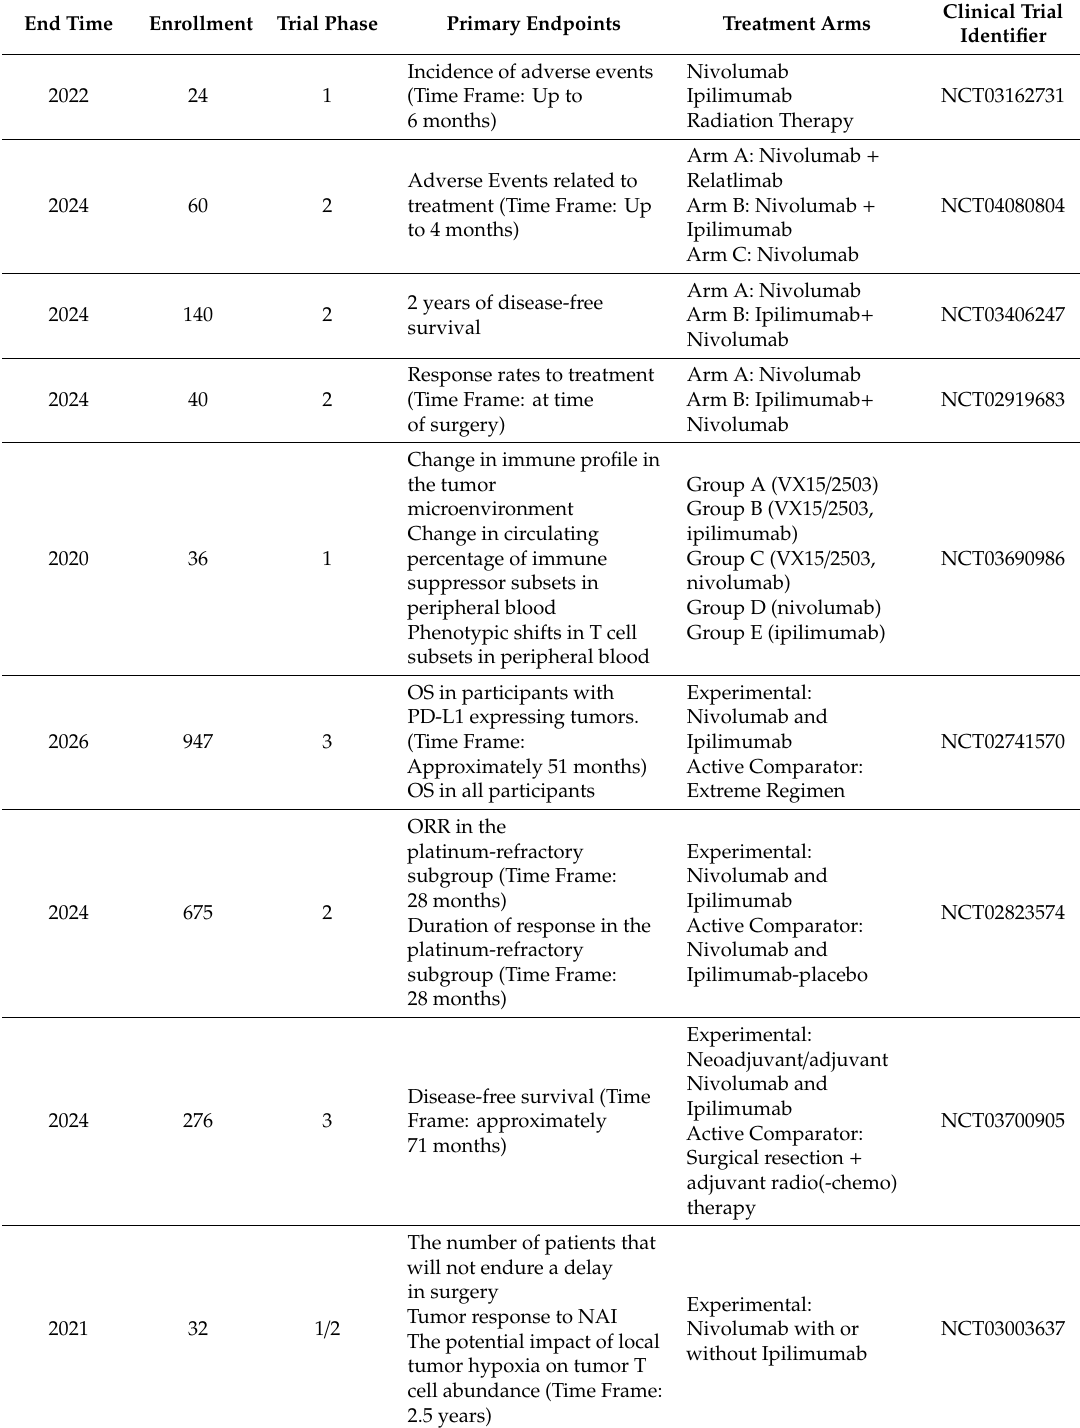
Table 8. Ongoing(untilJanuary2020)HeadandNeckCancertrialsevaluatingnivolumabplusipilimumab. End